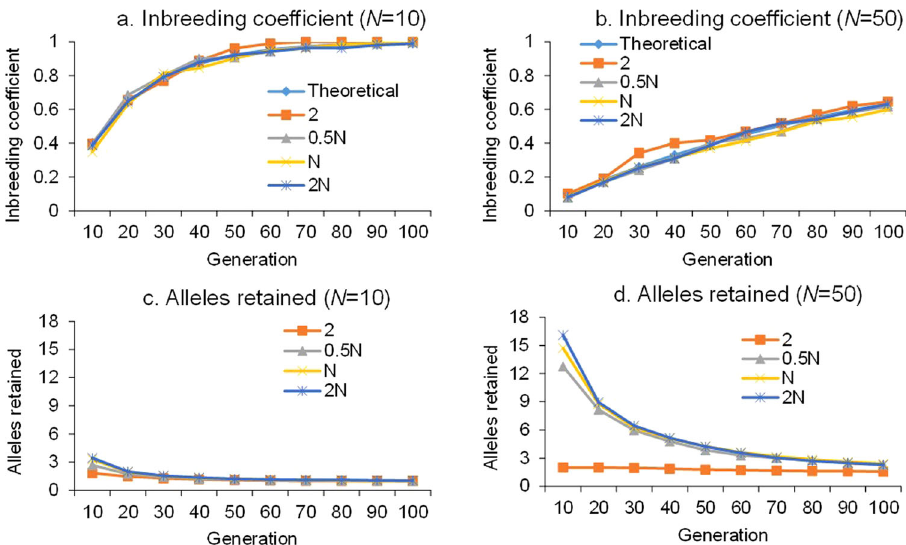
Fig. 1 Theoretical and simulated inbreeding coef fi cients and the observed allele numbers after 100 generations of random drift for two population sizes (N) and four initial numbers of alleles. a Inbreeding coef fi cient when N is 10. b Inbreeding coef fi cient when N is 50. c Alleles retained when N is 10. d Alleles retained when N is